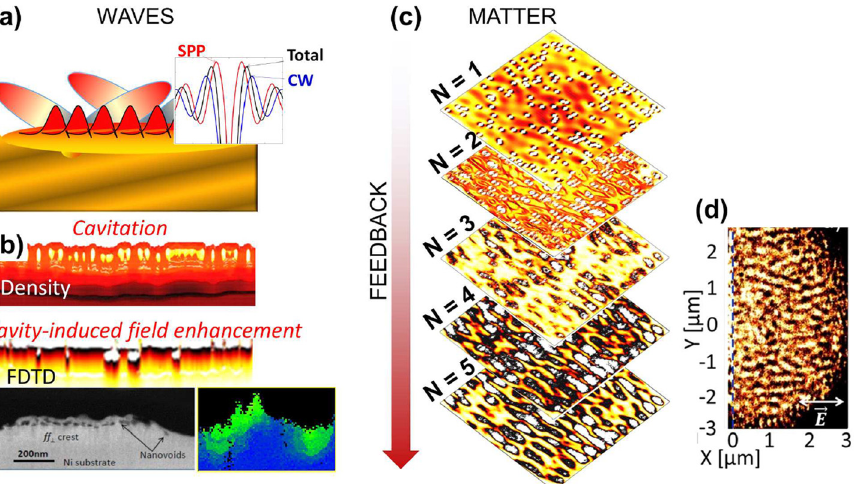
Figure 6: Laser-induced periodic surface structure (LIPSS) generation steps based on light and matter contributions. (a) Schematic of light scattering, of the emergence of surface waves, and of standing patterns, with examples of surface plasmon-polariton (SPP) waves and cylindrical waves (CW). (b) Rarefaction-induced cavitation and fi eld enhancement. The inset shows measurements of nanocavities (by transmission electron microscopy) [99] and structurally defected regions (concentration of defects measured by electron backscatter diffraction) [100]. (c) Gradual formation of ripples under multipulse excitation, with the emergence of a regulating feedback. (d) Small-scale self-arrangement driven by hydrodynamic instabilities on the